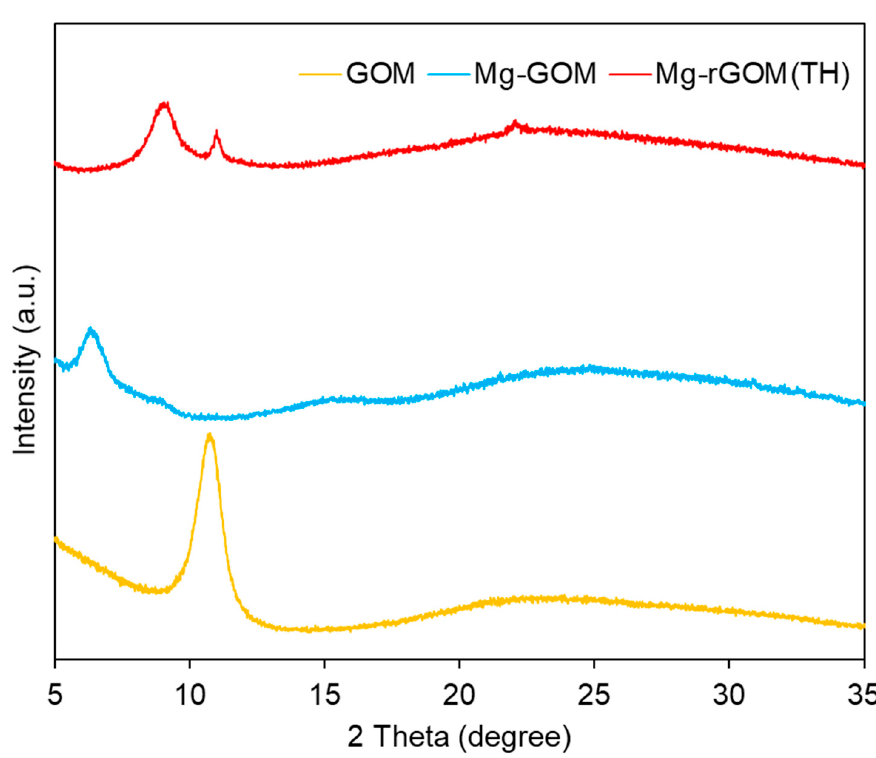
Figure 6. XRD patterns of the GOM series.